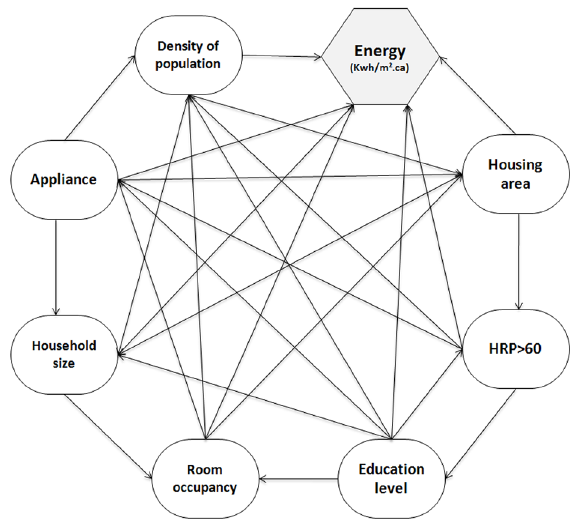
fig. 8. Path analysis containing all possible